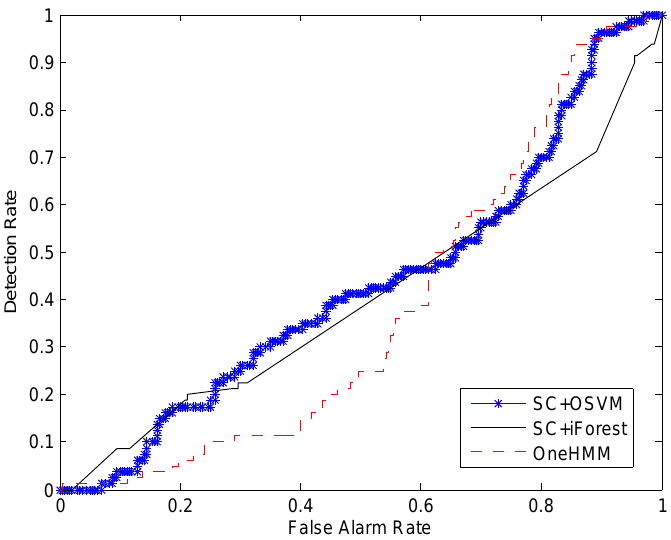
Figure 9. Comparison of the detection rate and the false alarm rate versus different numbers of training samples: training on 80 normal